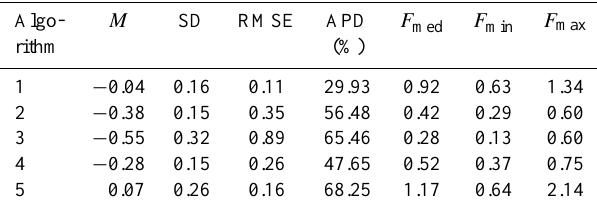
Table A1. Performance indices for relative errors in algorithms for Z EU estimates ( Z EU ( alg )) as compared with in situ Z EU measure- ments ( Z EU ( meas ))